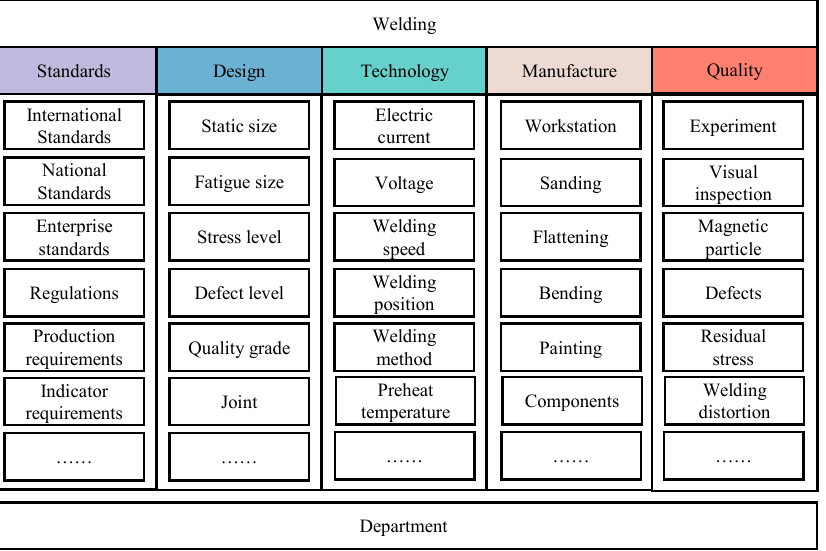
Figure 2. The welding knowledge model.